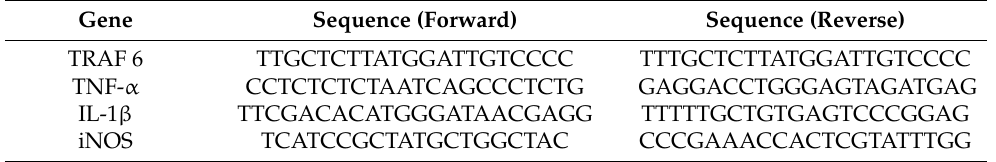
Table 3. mRNA sequence primers used in the RT-qPCR